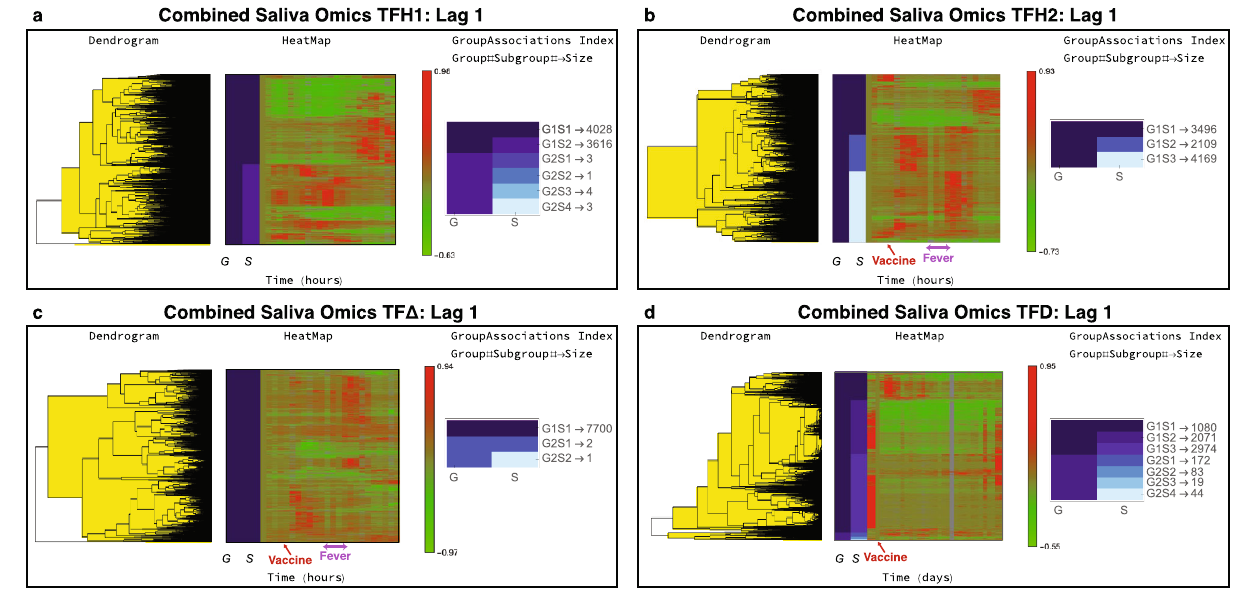
Figure 6. Combined saliva omics time series trends. The Lag 1 classification results from MathIOmica are shown for the different time frames. ( a ) During TFH1 the subject followed their normal routine. ( b ) During TFH2, the subject was vaccinated with PPSV23. For both TFH1 and TFH2 the first timepoint corresponds to 7 am. Vaccination took place at 10.30 am. The subject reported fever from 5.30 to 10 pm. ( c ) The TF (cid:31) results correspond to paired differences between TFH2 and TFH1 hourly points, to remove intra-day variation so as to focus on the perturbation vaccination responses. The plot is indicative of a phased response to the vaccine compared to the mRNA responses and a response that is again shifted compared to the reported fever (cf. Fig. 5c). ( d ) For the daily data, TFD, the corresponding vaccine timepoint is Day 3. There is a direct response the days following the vaccination. The EV omics dominate the information in this plot, compared to the mRNA in total saliva response (cf. Fig.